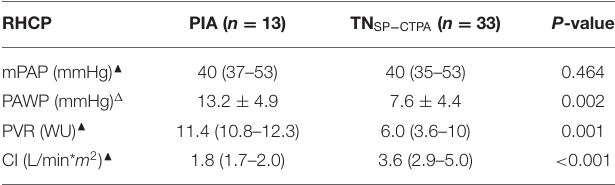
TABLE 4 | Comparison of RHCP in patients with PH between PIA and TN SP − CTPA groups.